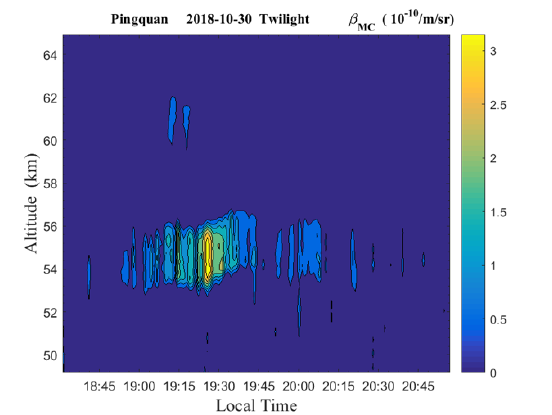
Fig. 3 . Contour plot of the volume backscatter coefficient showing the time evolution of MC layer observed at Pingquan (41°N, 118.7°E) in the twilight on 30 October